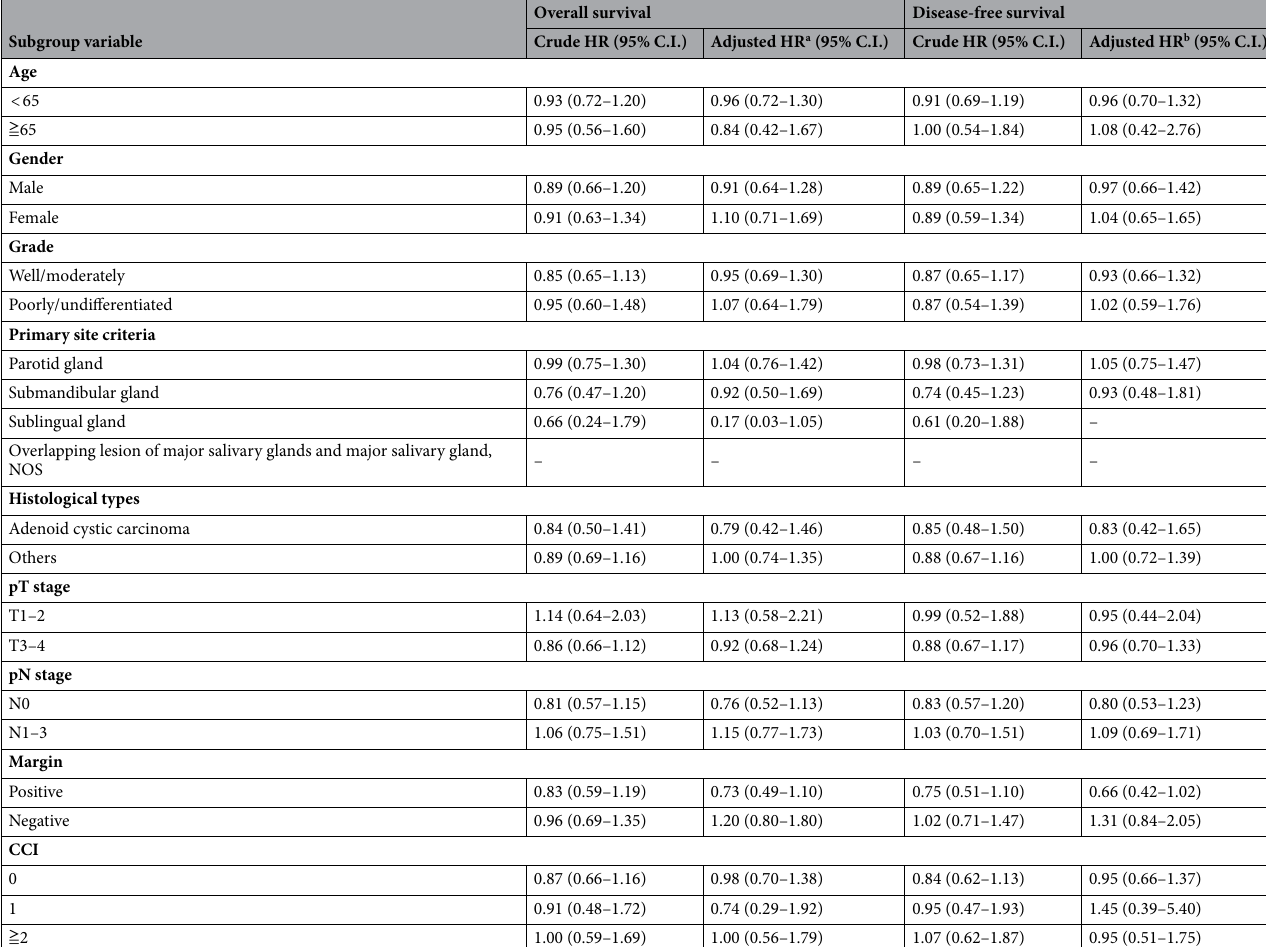
Table 4. Stratified analysis of chemotherapy use or not for the overall survival and disease-free survival according to different clinicopathological features, n = 395. RT radiotherapy, CRT chemoradiotherapy, CCI Charlson Comorbidity Index. a Adjusted model of overall survival between CRT and RT alone was shown as Table 3. b Adjusted model of cancer-free survival between CRT and RT alone was shown as Table